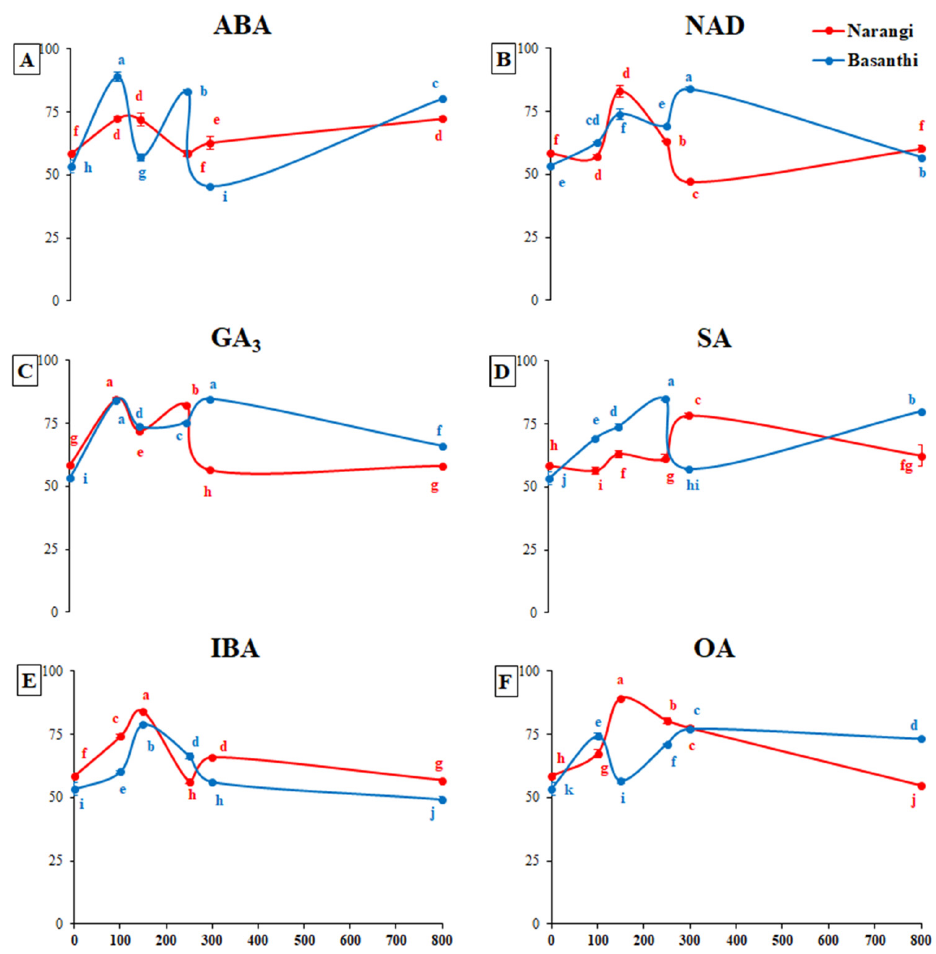
Figure 8. The reducing power ability (mg ∙ g − 1 ) of two cultivars of marigold (“Pusa Narangi Gainda” and “Pusa Basanthi Gainda”) as affected by different doses of (mg ∙ L − 1 ) ABA ( A ); NAD ( B ); GA 3 ( C ); SA ( D ); IBA ( E ) and OA ( F ). Same letters indicate non ‐ significant difference among treatments under Fisher’s least significant difference test ( p ≤ 0.05 ). Vertical bars indicate average ± standard error (three replications, under bi ‐ factorial CRD).